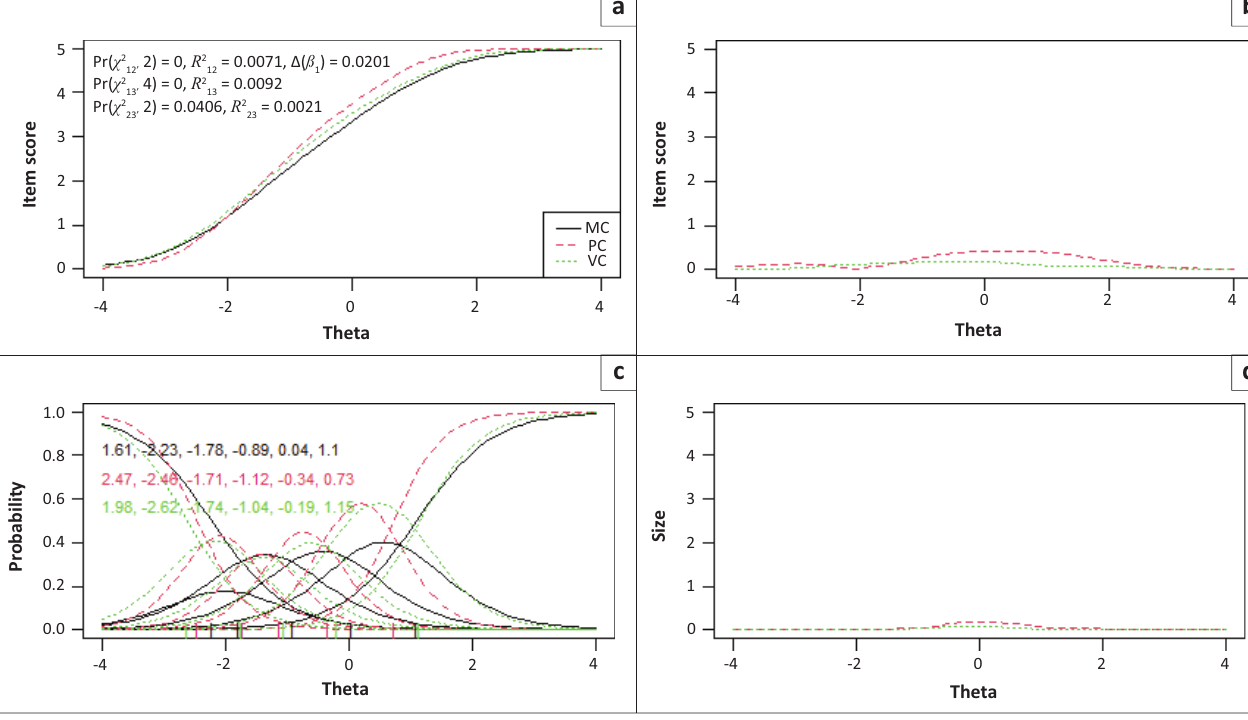
FIGURE 4: Graphical display of Item 2, which shows uniform and non-uniform differential item functioning with respect to campuses. (a) Items True Score Functions - item 2; (b) differences in items True Score Functions; (c) Item Response Functions; (d) Impact (weighed by